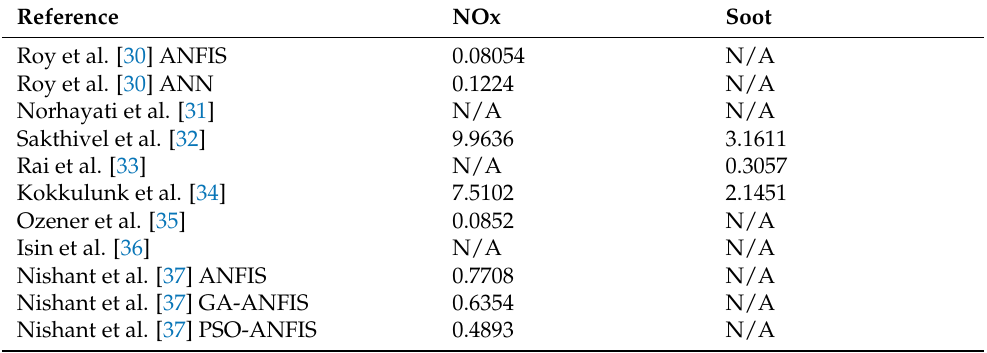
Table 6. Comparison of prediction capability of different techniques and the developed